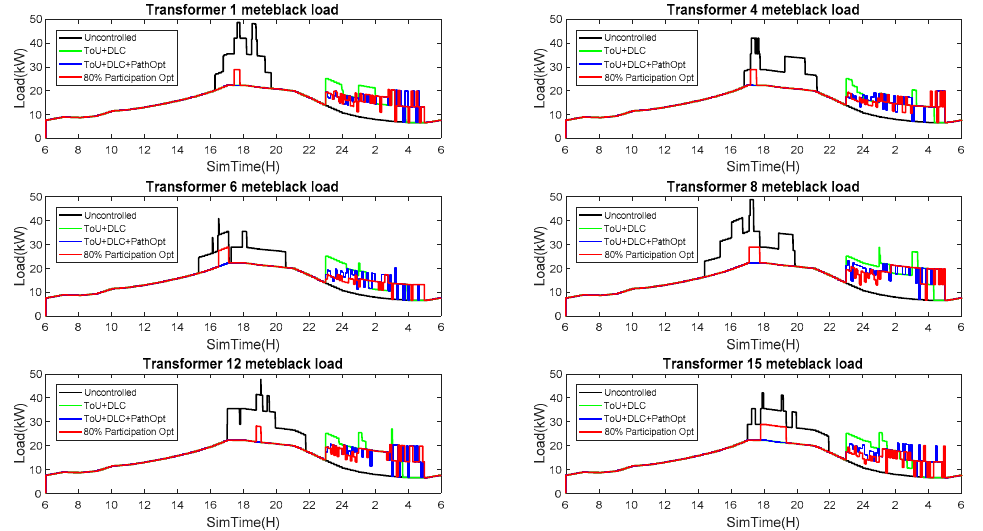
Figure 8. Transformer-level load profile for transformers in phase C with uncontrolled PEV charging, ToU + DLC charging, ToU + DLC + optimal control charging, and 80% participation rate of ToU + DLC + optimal control charging.